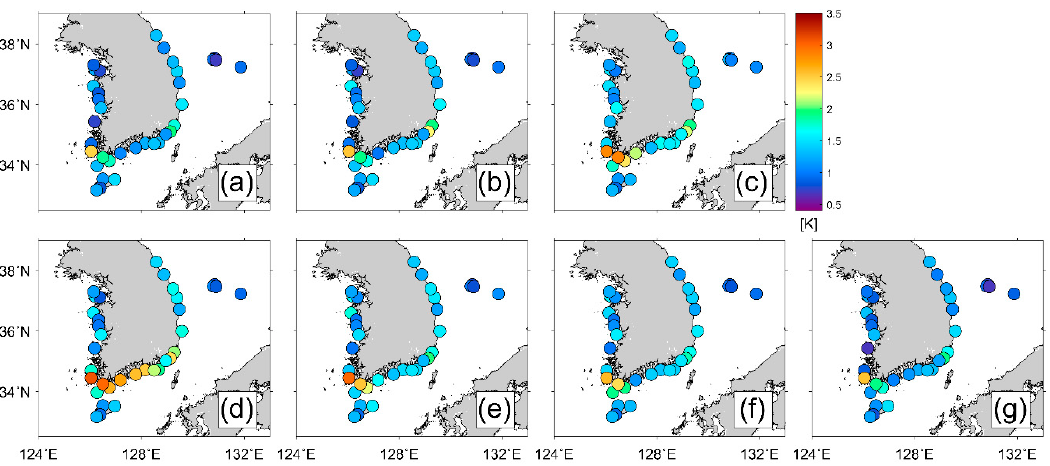
Figure 5. Spatial distribution of root-mean-squared error (RMSE) of sea surface temperature (SST) analyses at the locations of the coastal wave buoys—( a ) OSTIA; ( b ) CMC analysis; ( c ) OISST; ( d ) REMSS analysis; ( e ) MURSST; ( f ) MGDSST; and ( g ) Blended